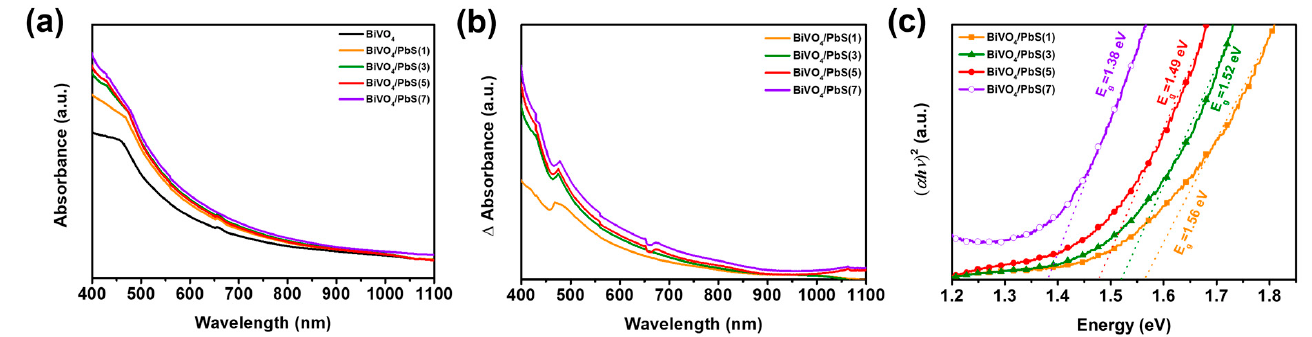
Figure 6. ( a ) Absorption spectra of bare BiVO 4 and BiVO 4 /PbS(n) QDs films (n: the number of PbS SILAR cycles). ( b ) Absorbance difference between bare BiVO 4 and BiVO 4 /PbS(n) QDs films. ( c ) Extrapolated plots of ( α h ν ) 2 vs. h ν achieved from the absorption spectra and utilized to obtain the band -gap of PbS QDs.